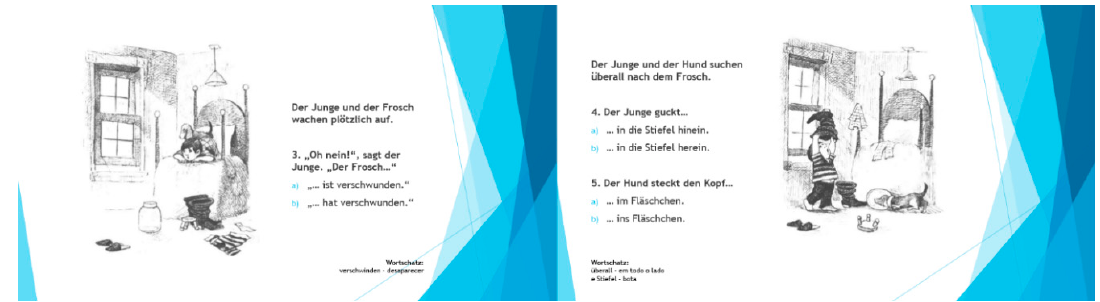
Figure A29. Posttest: Binary-choice recognition task.